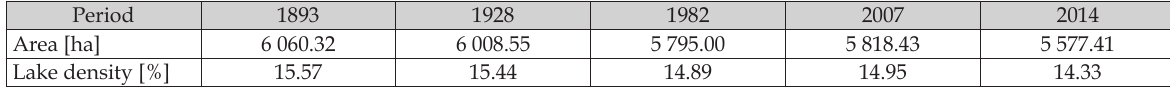
Table 2. Lake area and density for total data of the Iława Lakeland Landscape Park.